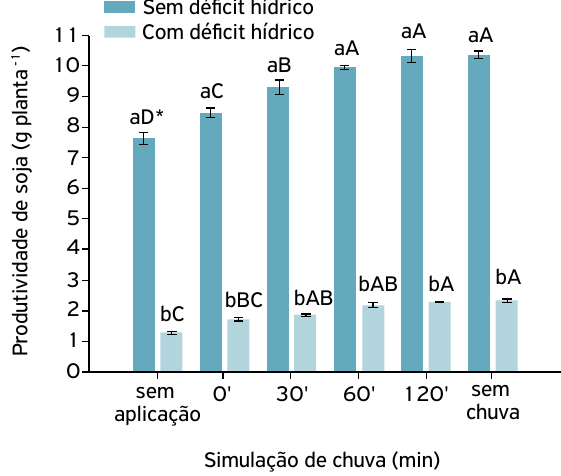
Figura 2. Severidade de Phakopsora pachyrhizi (%) na interação entre regimes hídricos e intervalos de simulação de chuva após a aplicação aos 30 dias após a aplicação. Itaara – RS, 2013.